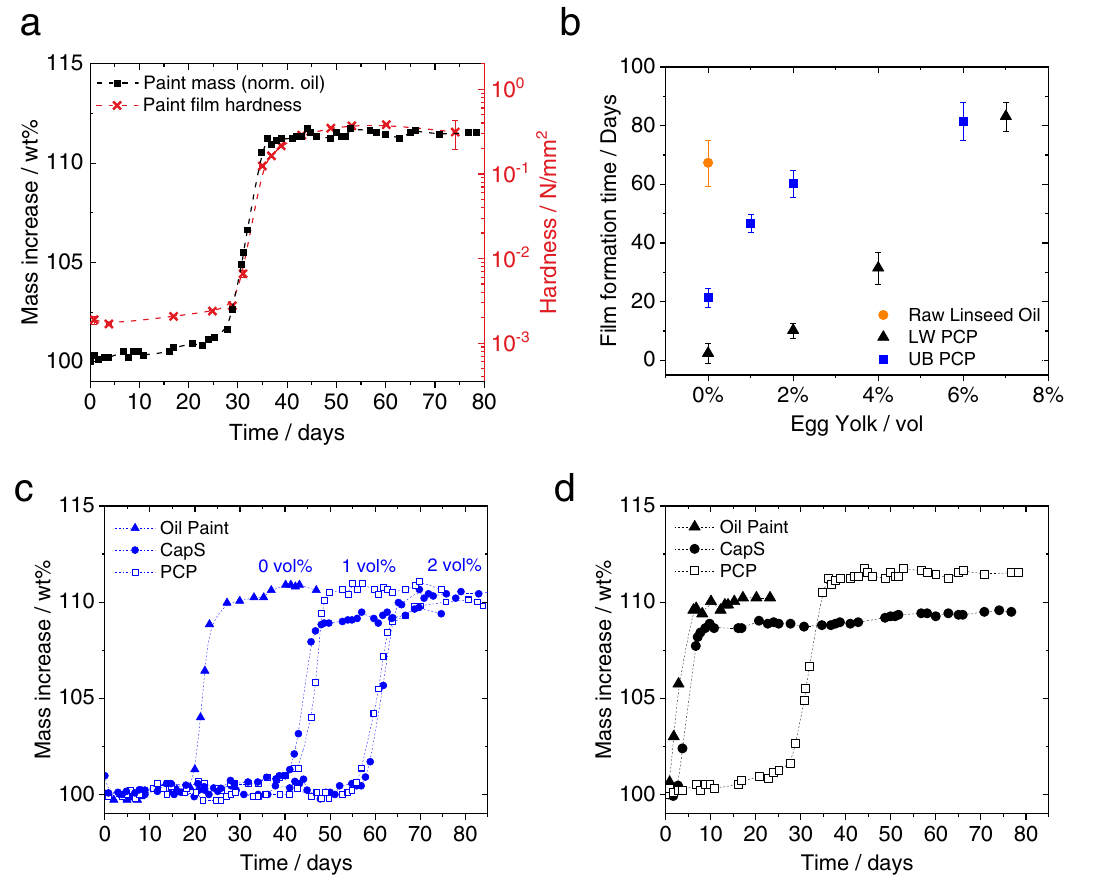
Fig. 6 | Curing kinetics and fi lm formation of oil paints. a Displays the compar- isonbetweenthemassuptake(blacksquare)ofaprotein-coatedpaint fi lm(LWPCP at 4vol% of EY), normalized to its oil content, over time and the corresponding changeinmechanicalhardness(redcross).Theerrorintervaldenotesthestandard deviation calculated from measurements performed at least in triplicate. b Film formation time (the time at which the paint has reached its maximum weight change) vs. egg yolk content for PCP-type paints; error bars represent the interval